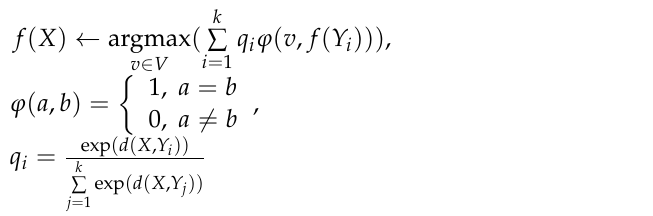
Table 1. The criteria for determining the type of Lenke classification.